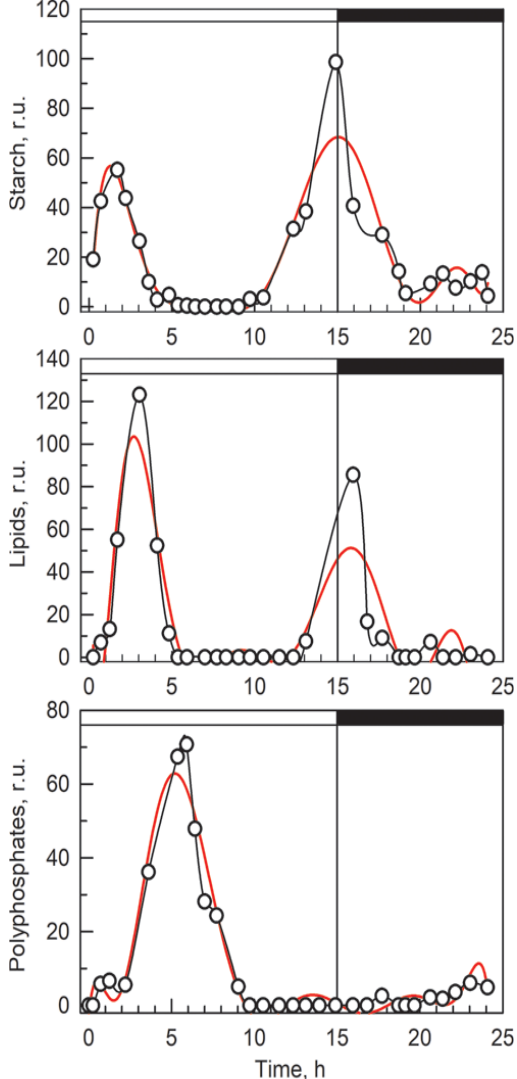
Figure 6. Time evolution of starch (top), lipids (middle), and polyP (bottom) levels in the cells during the cell cycle as determined from the Raman maps. Black lines connect experimental points. Red lines are splines averaging neighboring values.